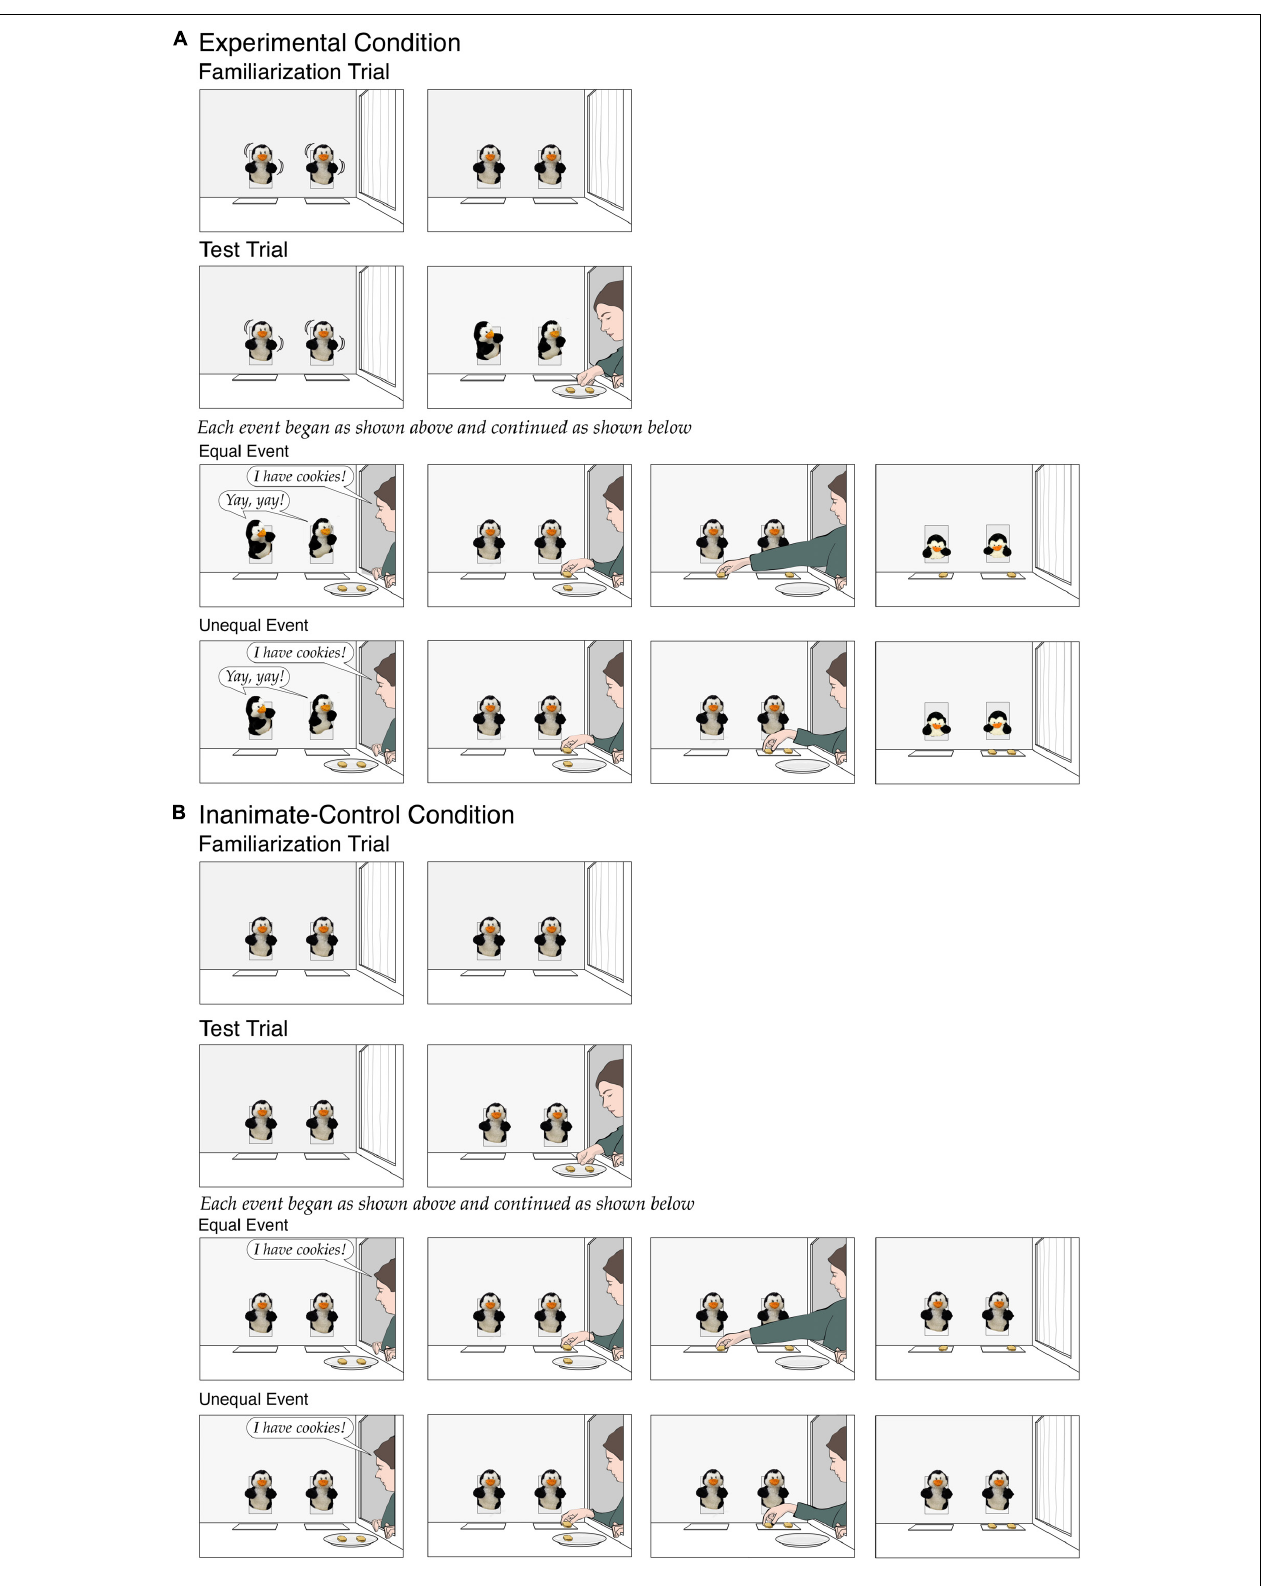
FIGURE 1 | Schematic depiction of the events shown in the experimental condition (A) and the inanimate-control condition (B) of Experiment 1.